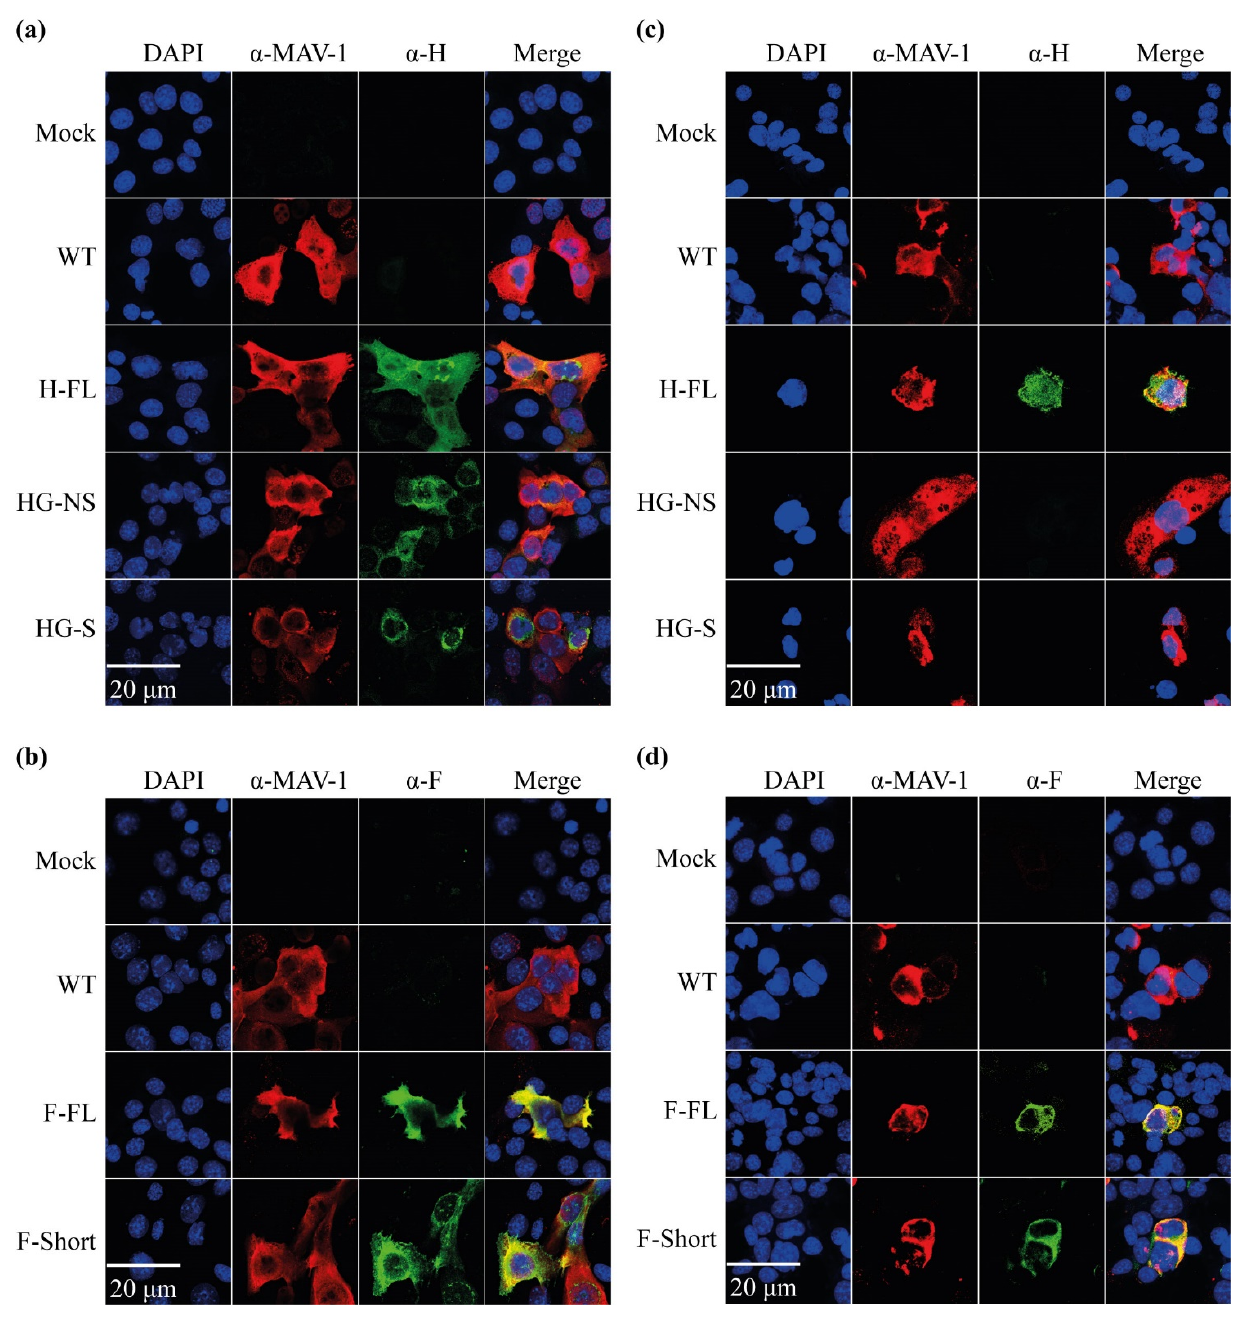
Figure 2. Validation of MAV-1 mediated expression of CDV antigens in vitro. The different MAV-1 strains were grown on 3T6 cells for 72 h (MOI of 0.01). Cells were then fixed and permeabilized (panels ( a , b )) or not (panels ( c , d )). Fluorescent immunolabeling was performed using mouse polyclonal antibodies against MAV-1 detected by Alexa 568 goat anti-mouse polyserum. CDV antigens were labeled with rabbit anti-H ectodomain (panels ( a , c )) and anti-F ectodomain (panels ( b , d )) detected by Alexa 488 goat anti-rabbit polyserum. Cells nuclei were visualized with